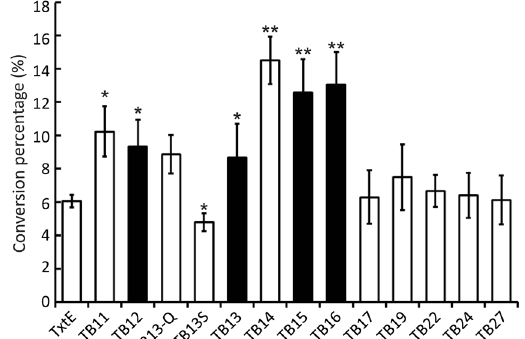
Figure 2. Relative nitration activity of TxtE and chimeric TxtE-BM3R variants. All reactions contained 0.5 mM Trp and 1.5 µ M P450. The TxtE reaction was further supplemented with 0.43 µ M spinach Fer and 0.33 µ M Frd. The reactions were incubated at 20 °C, 300 rpm for 30 minutes. All experiments were repeated at least three times. The results of TB12, TB13, TB15, and TB16 were shown as black bars. Chimeras showed significant difference in nitration activity compared to the wild type TxtE were indicated as * P < 0.05 or ** P <